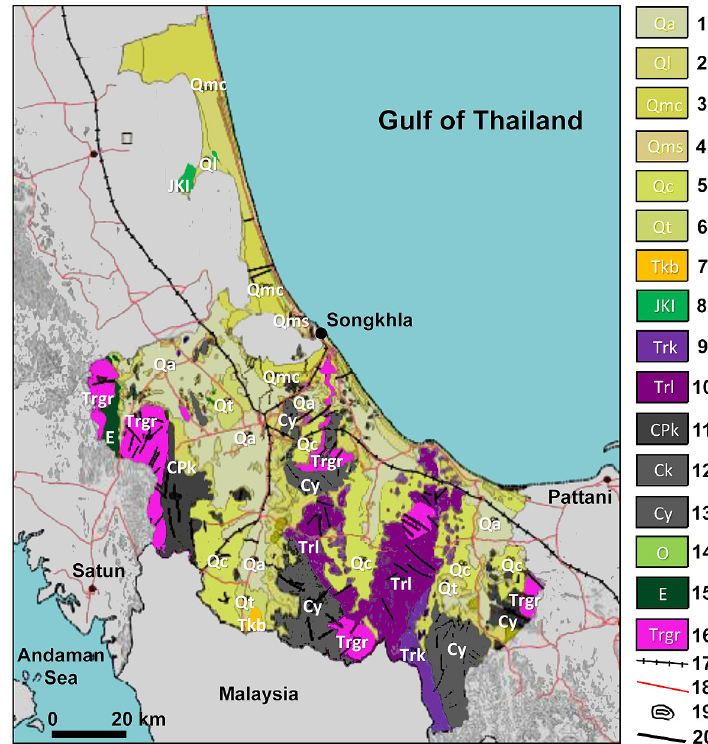
Fig. 2. Geological map of Songkhla Province (Adopted from DMR,